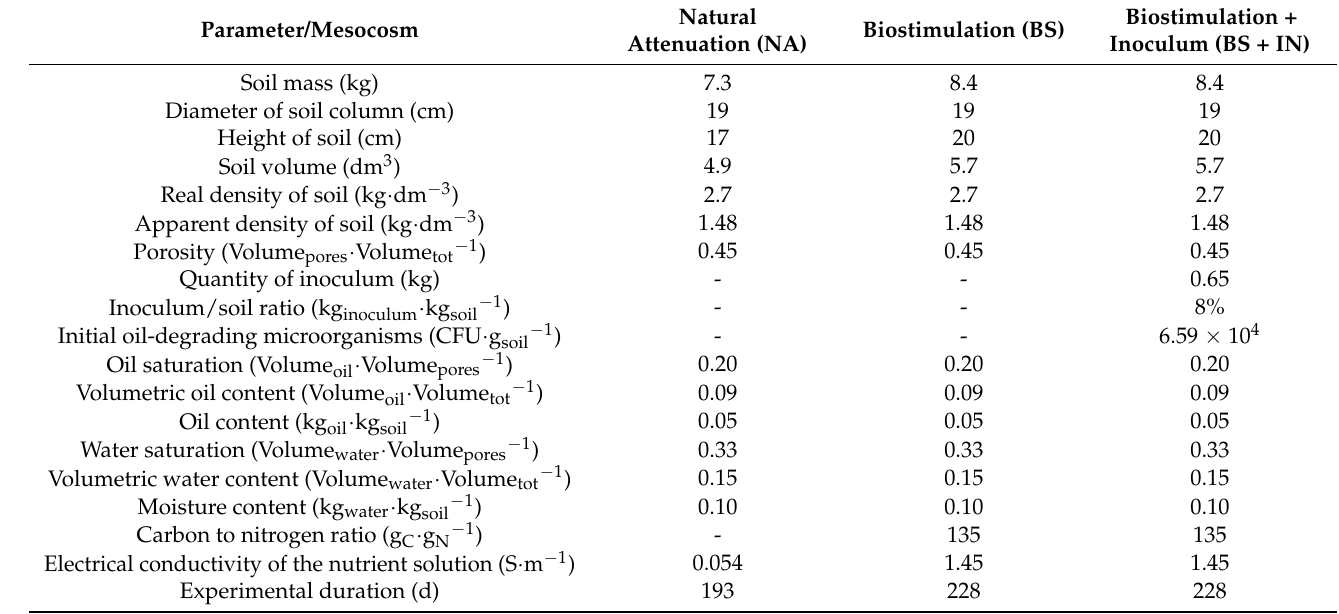
Table 1. Main parameters of the